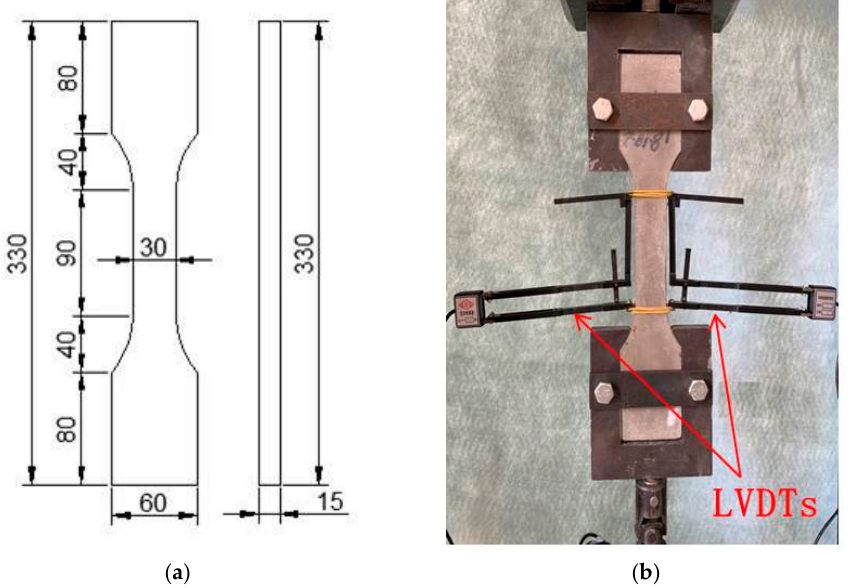
Figure 7. Uniaxial tensile test. ( a ) Diagram of specimen size (Unit: mm); ( b ) photo of the test device.